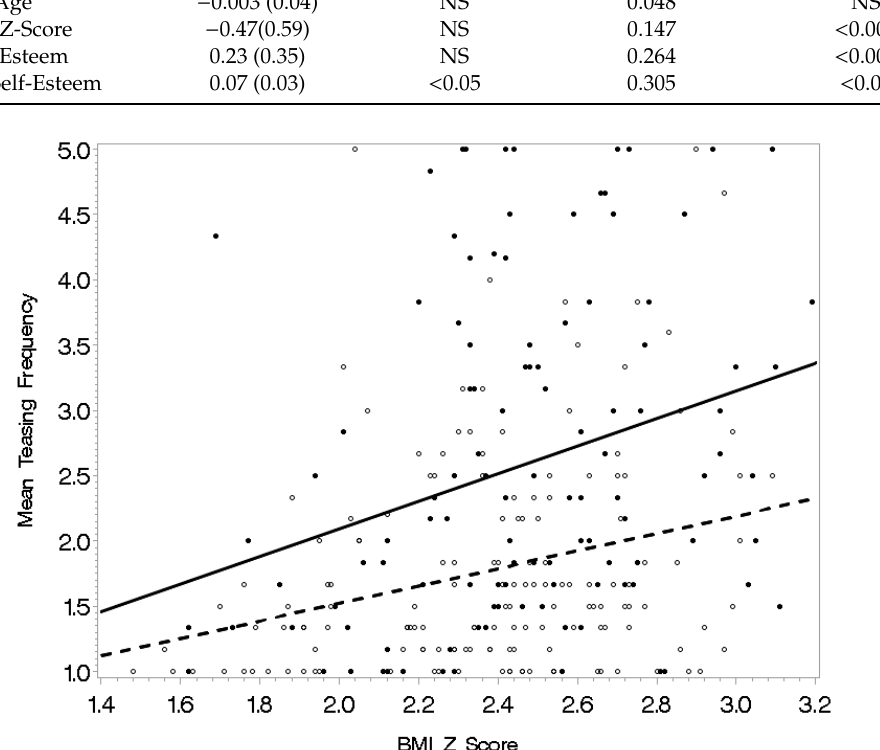
Figure 1. Body image as a moderator: BMI z-scores related less to weight-related teasing frequency for adolescents with a more positive body image (dashed line) compared to those with a more negative body image (solid line).